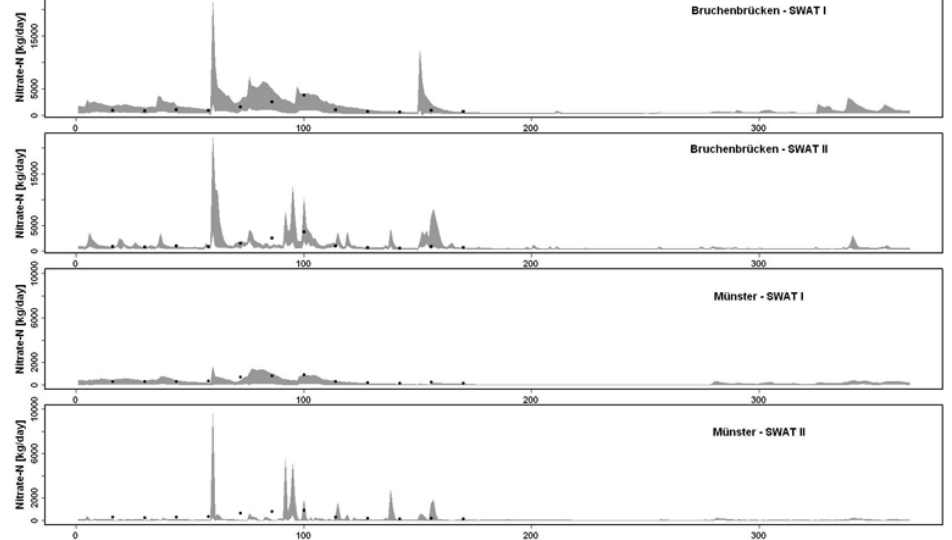
Fig. 6. Span of simulated (shaded grey) and observed (black dots) nitrate loads for the gauging stations Bruchenbr¨ucken and M¨unster for the year 2008 and the parameter ensembles of SWAT I and SWAT